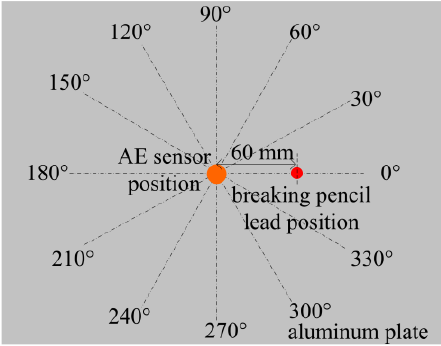
Figure 13. Direction sensitivity experiment. Table 2. Average amplitude of broken lead signal detected by FOR and PZT AE sensors.